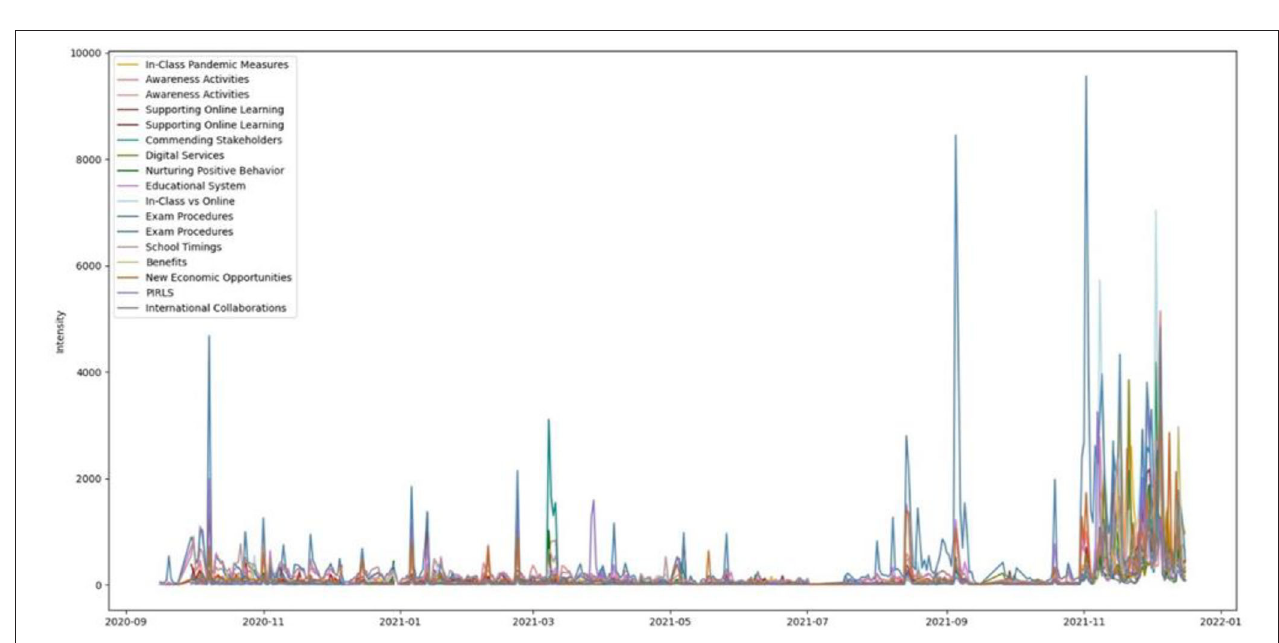
FIGURE 4 | Temporal progression of parameters